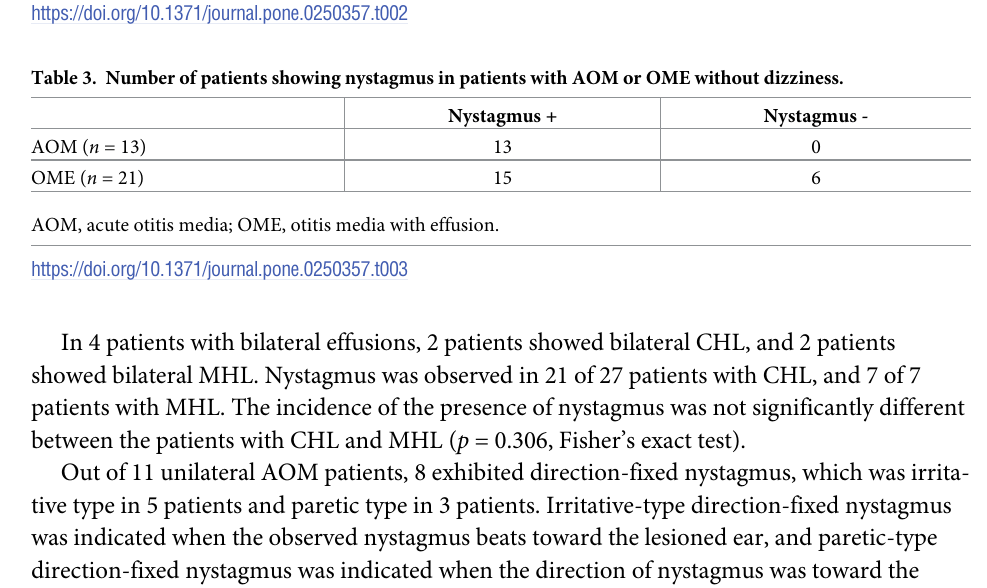
Table 3. Number of patients showing nystagmus in patients with AOM or OME without dizziness.